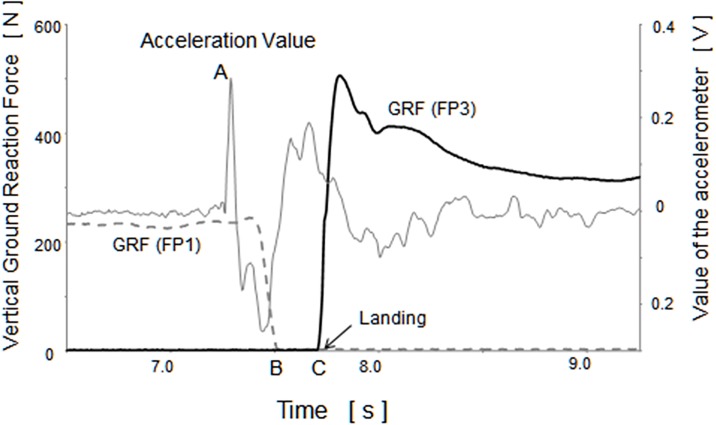
Definition of data-analysis segments from the ground reaction force and the acceleration value.A: initiation of the perturbation B: onset of the stepping C: LandingA-B: perturbation-stepping(PS) phaseB-C: single-stance(SS) phase.